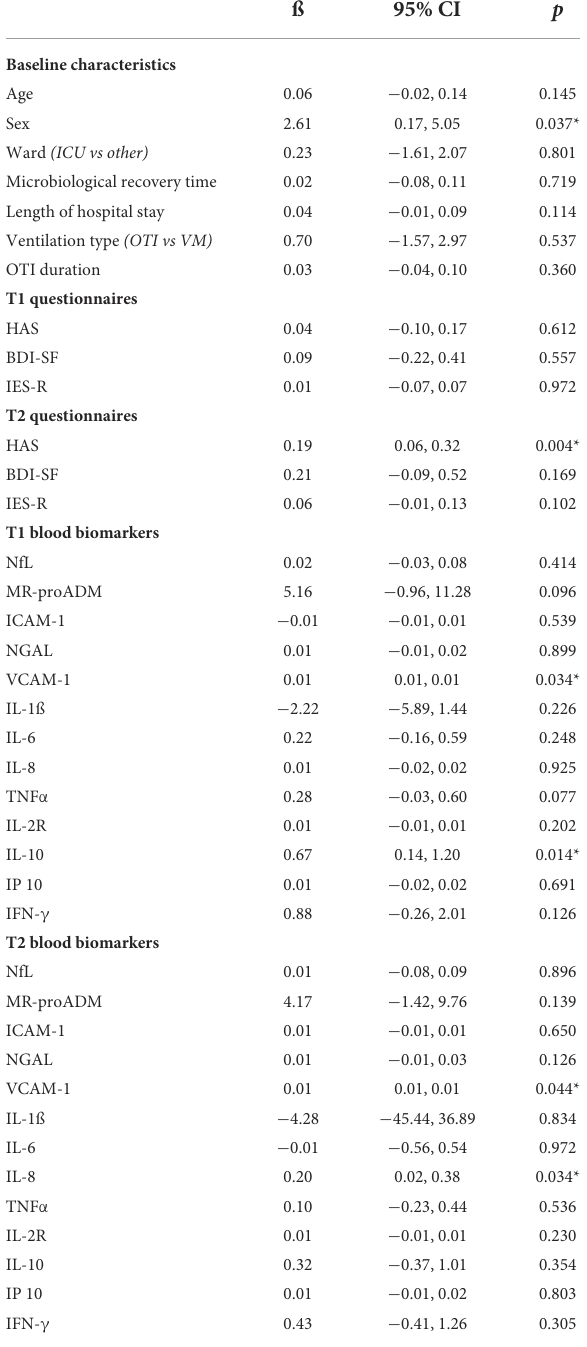
TABLE 5 Univariate linear regression for PSQI total score at T2 study visit. ß 95% CI